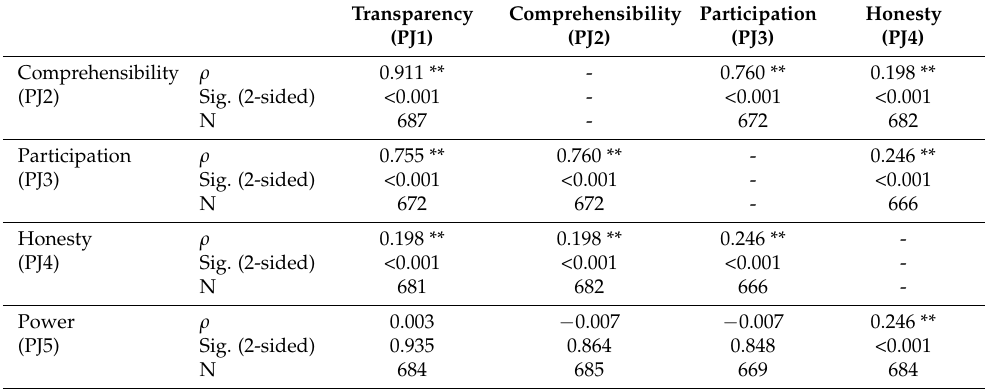
Table 3. Correlations between factors of procedural justice (own